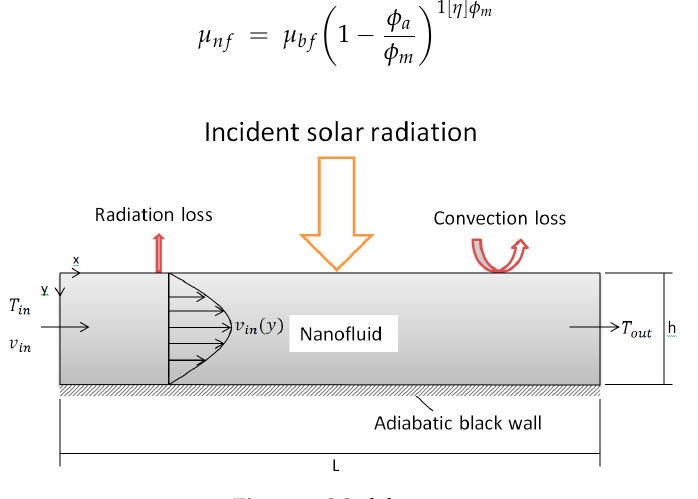
Figure 1. Model Figure 1. Model setup.